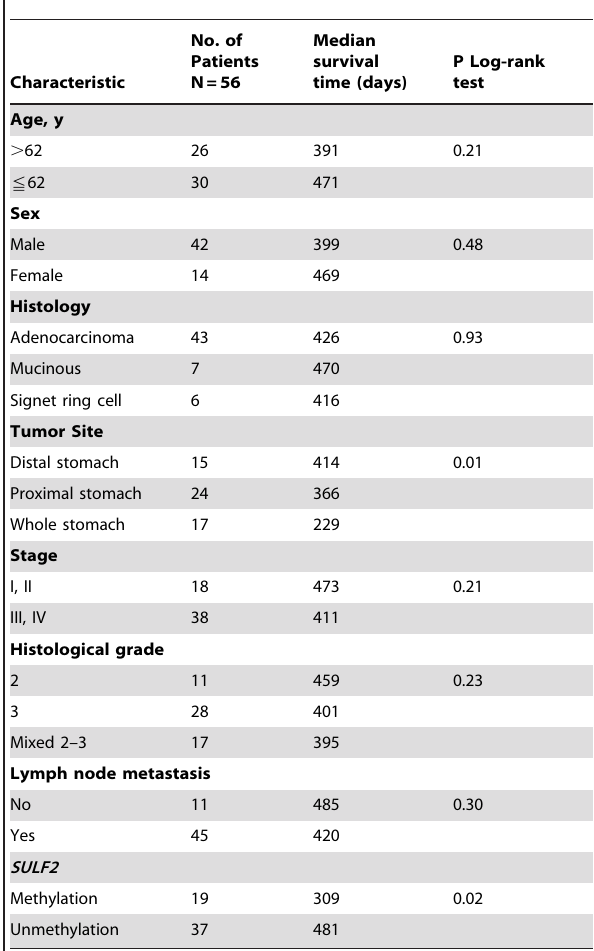
Table 5. Clinical factors associated with overall survival.